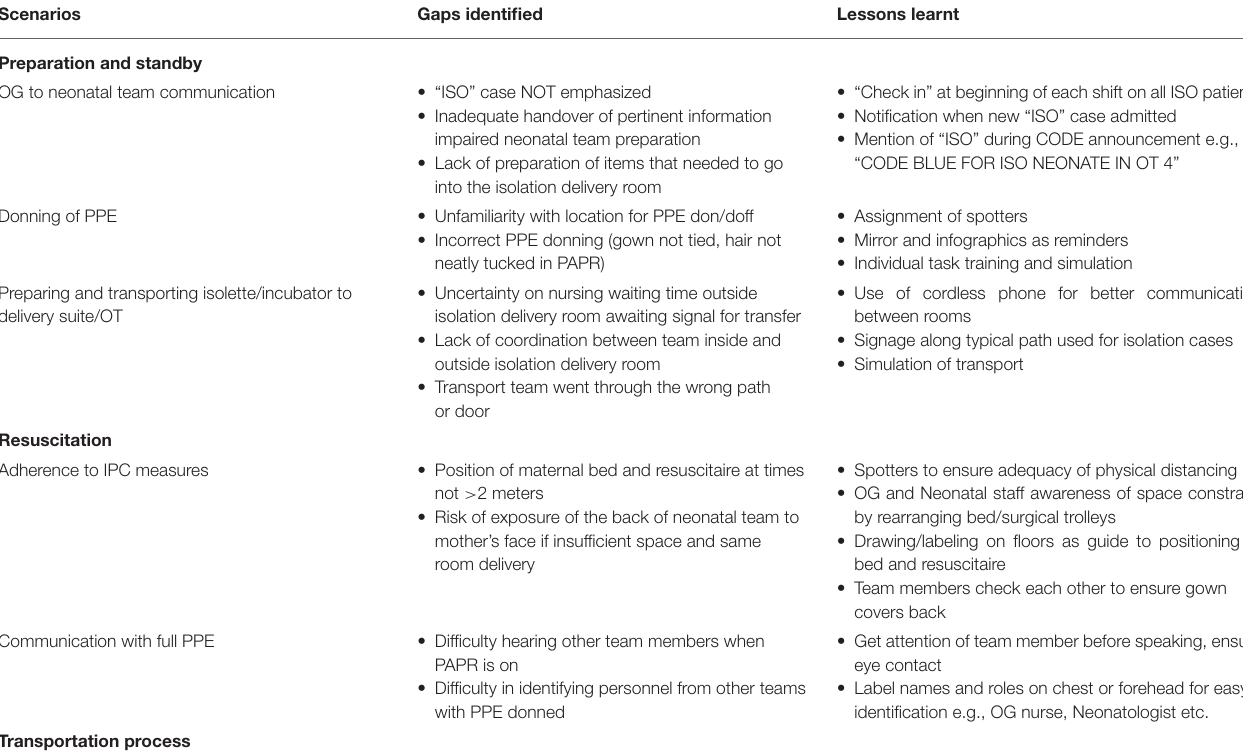
TABLE 1 | Challenges met and lessons learnt during simulation